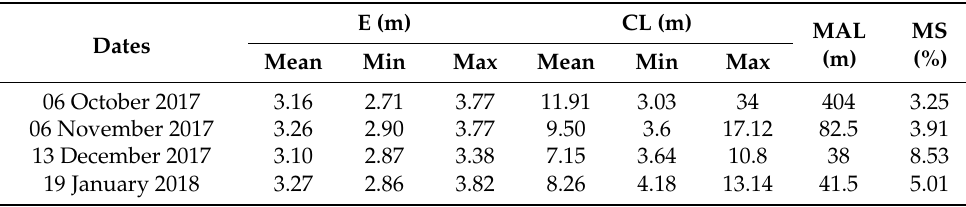
Table 1. Characteristics of the rhythmic features in the UAS-derived DEMs and mosaics (E = elevation, CL = cross- shore length, MAL = mean along-shore length, MS = mean slope). Table 2. Characteristics of the rhythmic features in the Google Earth imagery (W = wavelength, CL = cross-shore length, MAL = mean along-shore